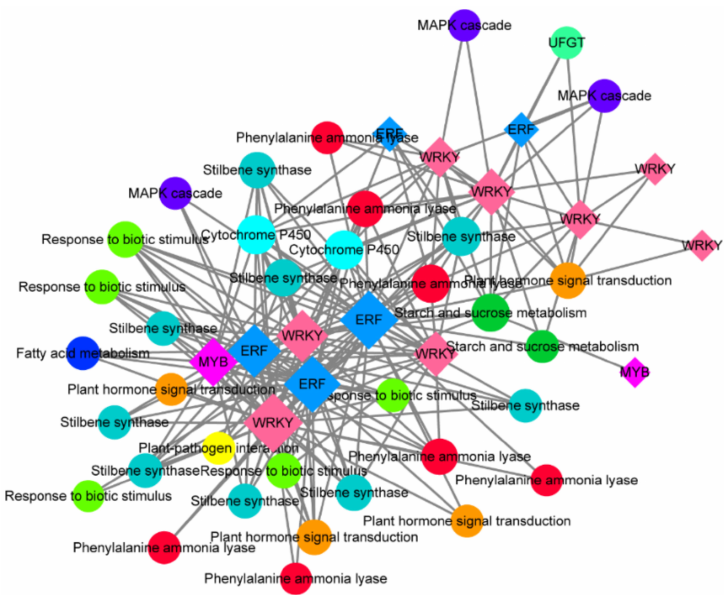
Figure 7. Co-expression network of transcript factor genes with their target genes in Vitis davidii Föex berries incubated with Colletotrichum viniferum